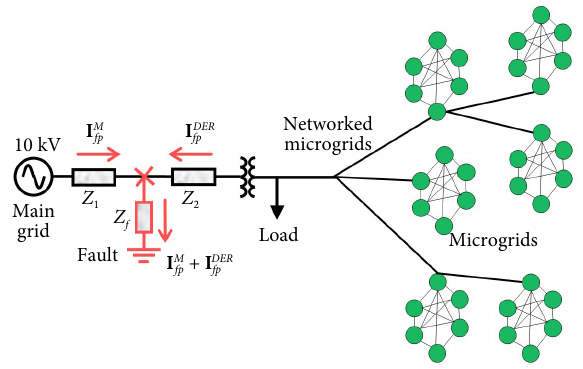
Fig. 17 Diagram of studied system with 36 microgrids for scalability analy- sis. putations. This would result in similar computation time irre- spective of the number of microgrids. Figure 18(b) is microgrid 1’s phase currents sent from the controller to RTDS simulators. a